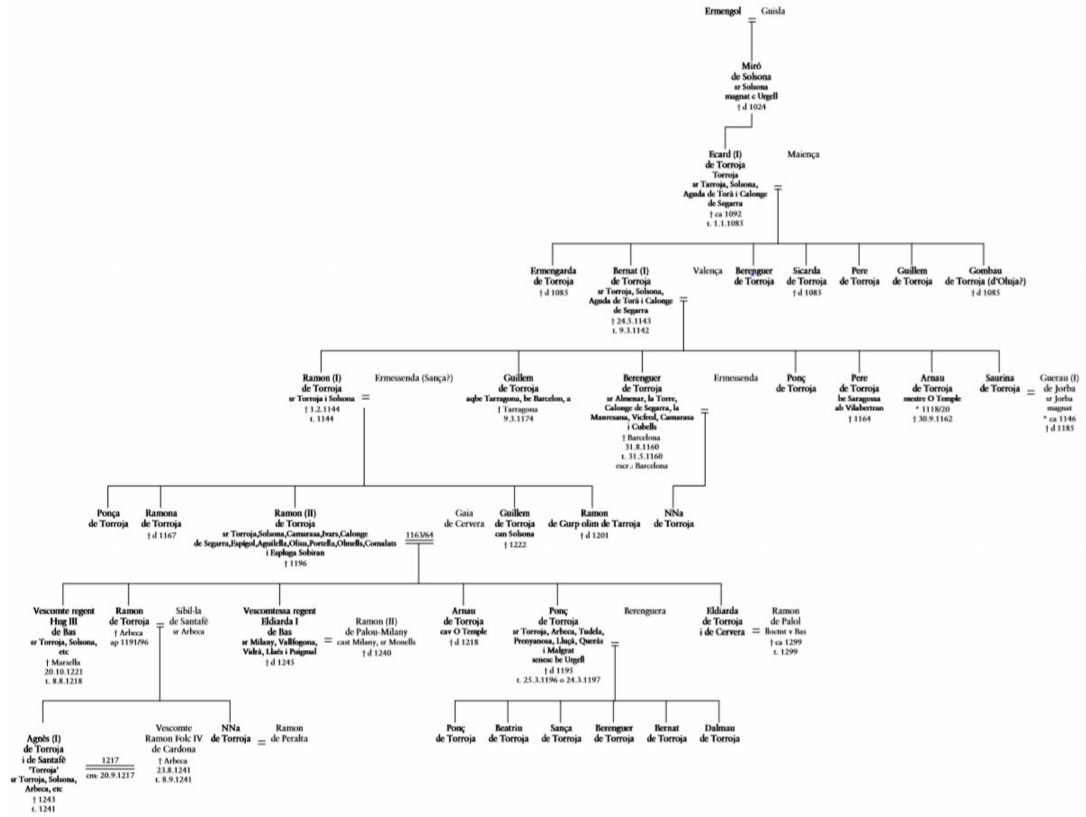
Figure 1. Genealogical tree of the family